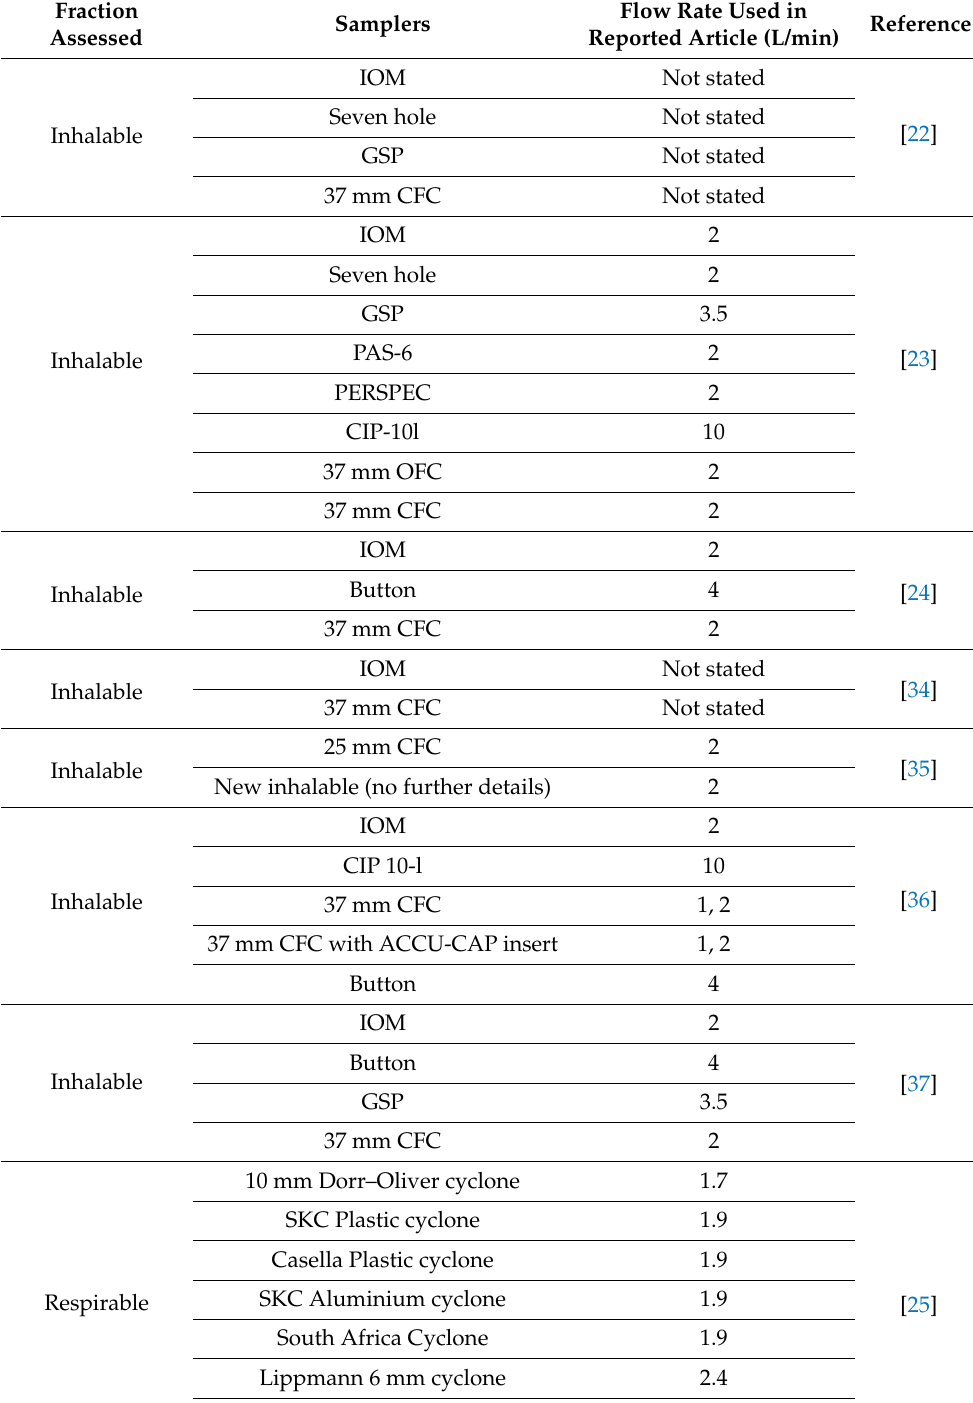
Table 1. Cont . Fraction Assessed